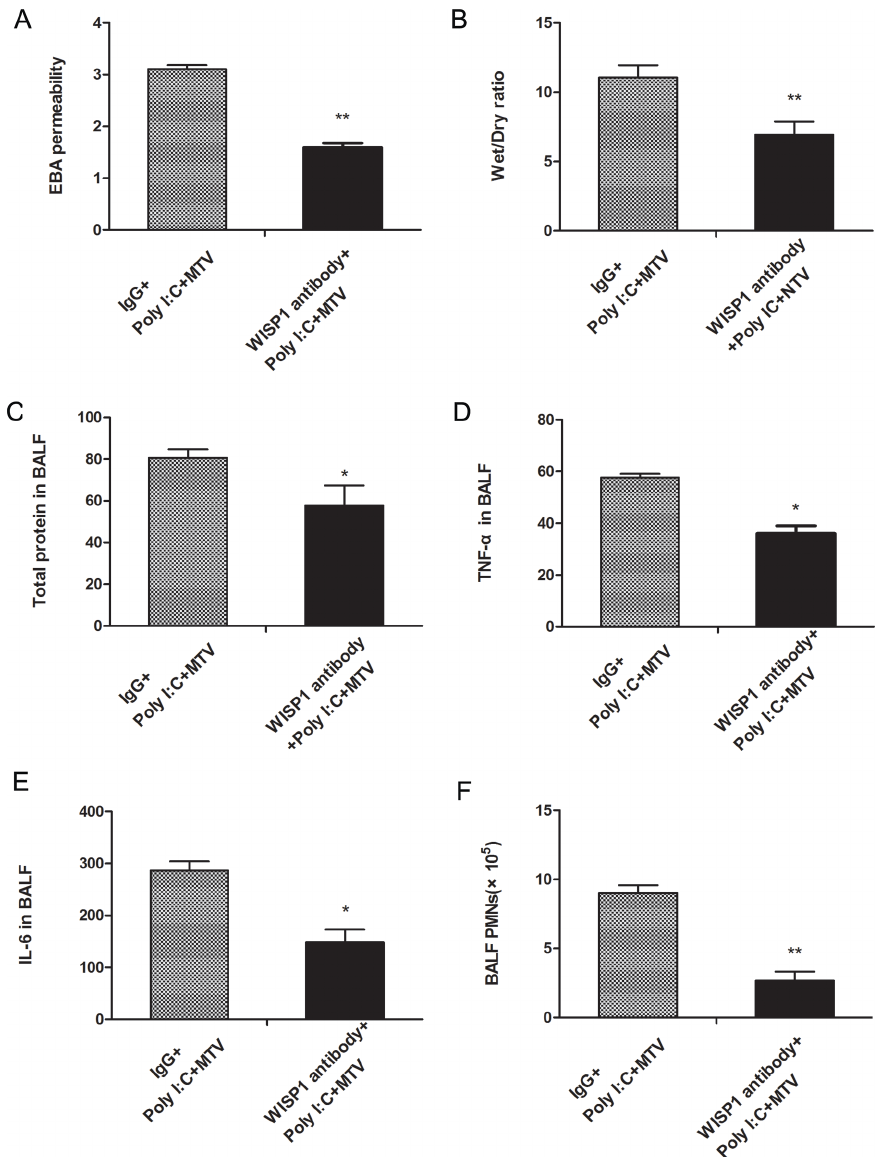
Figure 4. Effects of anti-WISP1 treatment on (A) EBA permeability, (B) wet:dry ratio of lungs, and (C) levels of total protein, (D) TNF- α and (E) IL-6, as well as (F) PMNs numbers in BALF at 4 h after poly(I:C) and MTV treatment. Animals received the anti-WISP1 block- ing antibody or control IgG i.p. 1 h before mechanical ventilation. Data are presented as mean ± SEM (n = 10) and compared by paired t test. For comparing the anti-WISP1 group with the IgG group * P < 0.05, ** P <